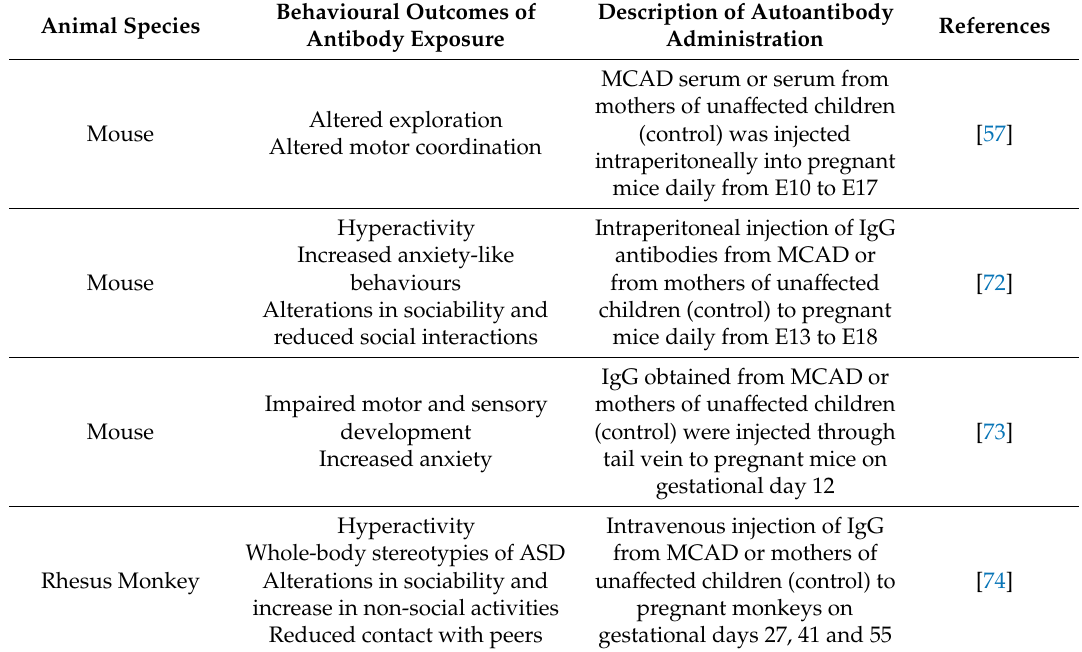
Table 3. Animal studies looking at behavioural correlates of ASD in o ff spring of pregnant dams injected with anti-brain antibodies from MCAD. Behavioural Outcomes of Description of Autoantibody Animal Species Antibody Exposure